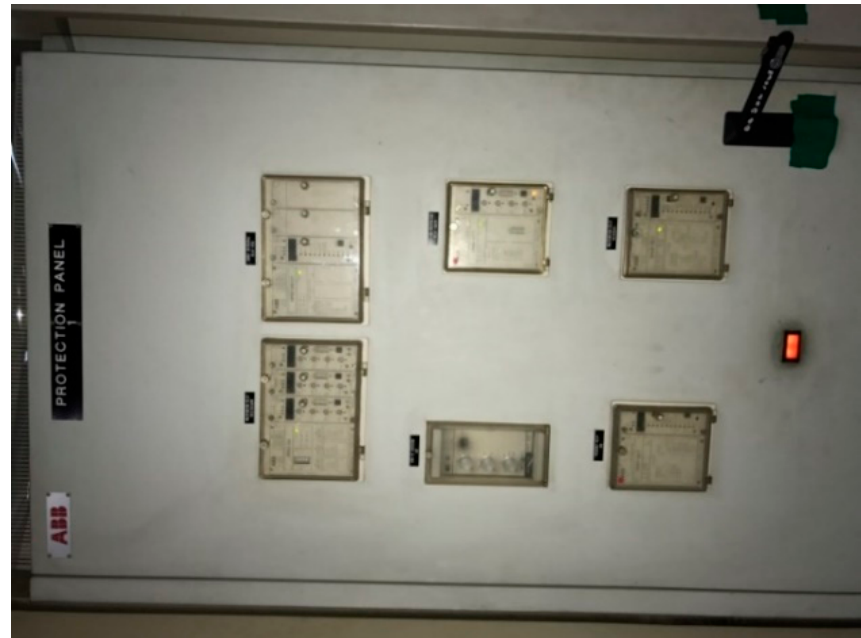
Figure 34. Operation of protection panel.